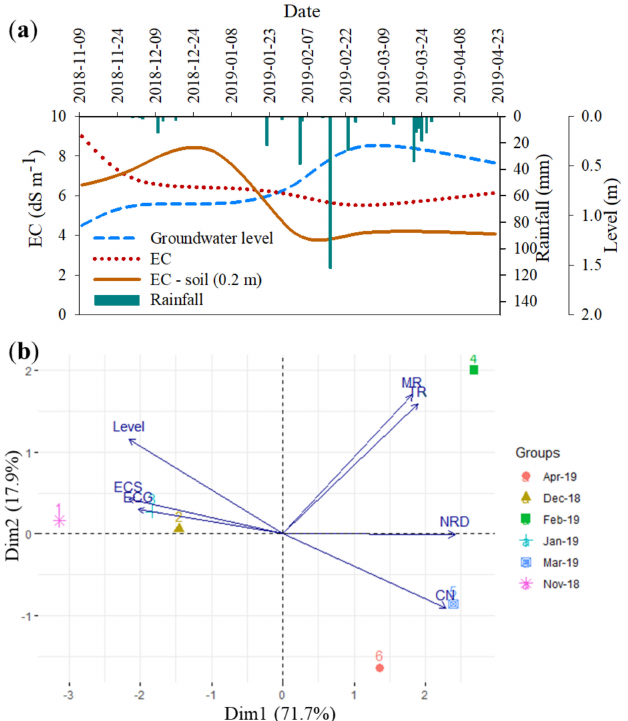
Figure 8. Groundwater level and electrical conductivity (EC) for the water table and for the soil (EC–soil (0.2 m)) and daily rainfall ( a ). Principal components analysis using Dim1 and Dim2 for groundwater level (Level). Groundwater electrical conductivity (ECG) and soil electrical conductivity (ECS). Number rainy days (NRD), total rainfall (TR), maximum rainfall (MR), and climatological normal (CN), and results for the variance of Dim1 and Dim2 ( b ) for sorghum